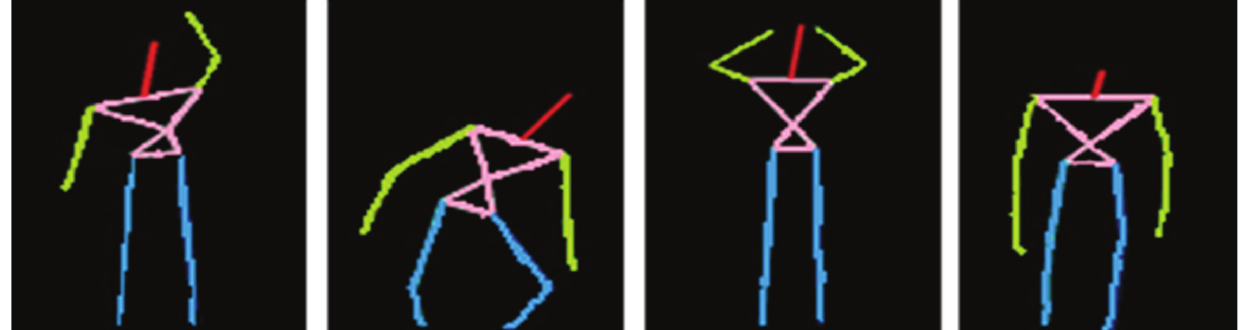
Figure 8: Samples of human skeleton model for different activities.